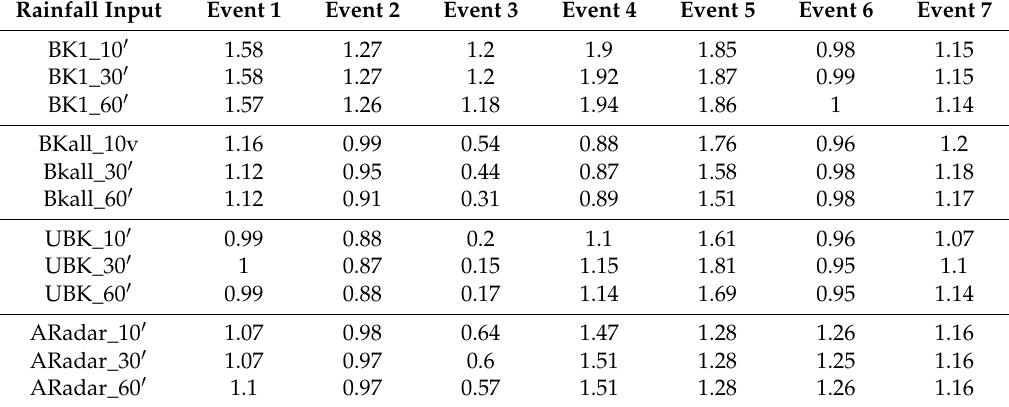
Table 5. Observed–modelled RMSE for dissolved oxygen concentration (five